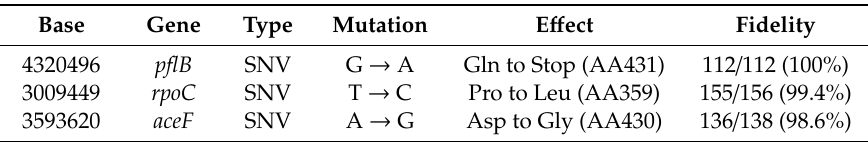
Table 4. Variant analysis of JG1295 compared to JG991. Represented are variants with a frequency of above 90% and a coverage of 20 ×